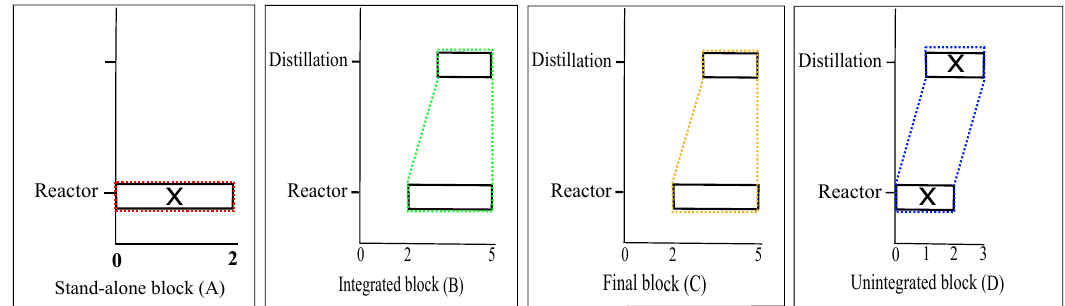
Figure 7. Fundamental building blocks for optimal schedule of BR-S